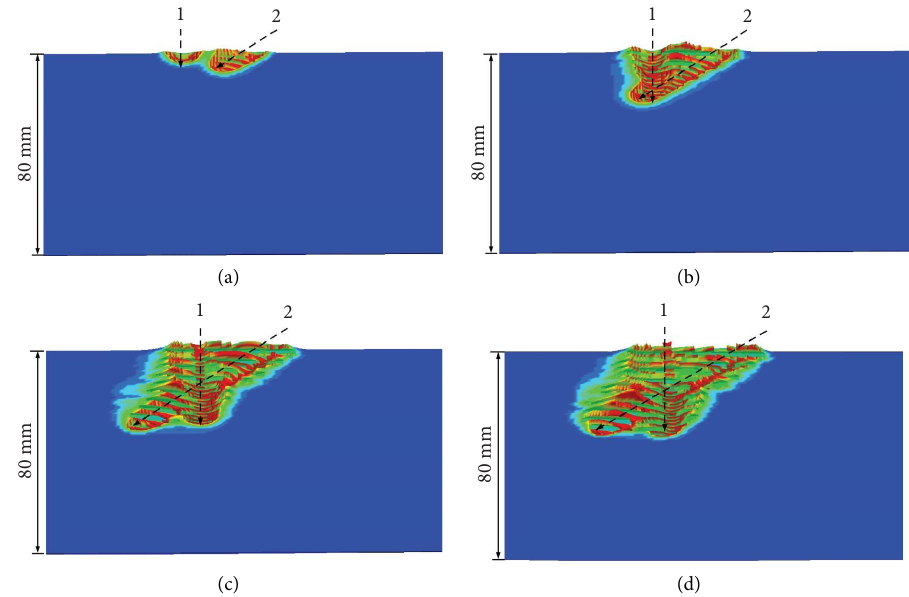
Figure 14: Cloud diagram of joint damage strain process of impact front. (a) 0.025ms. (b) 0.075ms. (c) 0.225ms. (d)